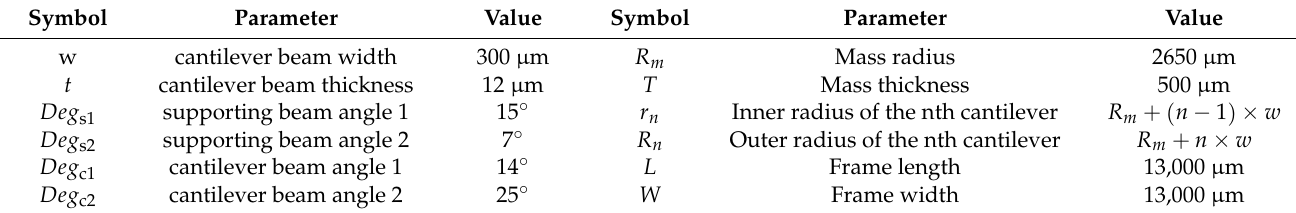
Table 1. Physical dimensions of the Micro-Electro-Mechanical Systems (MEMS) sensor